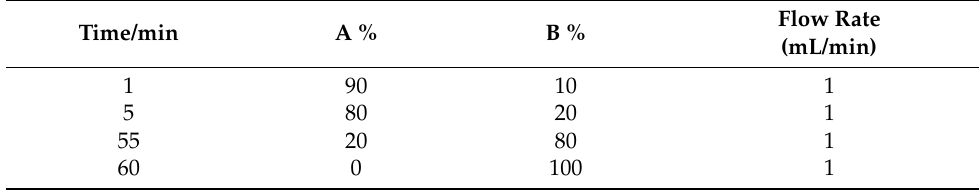
Table 5. HPLC detection